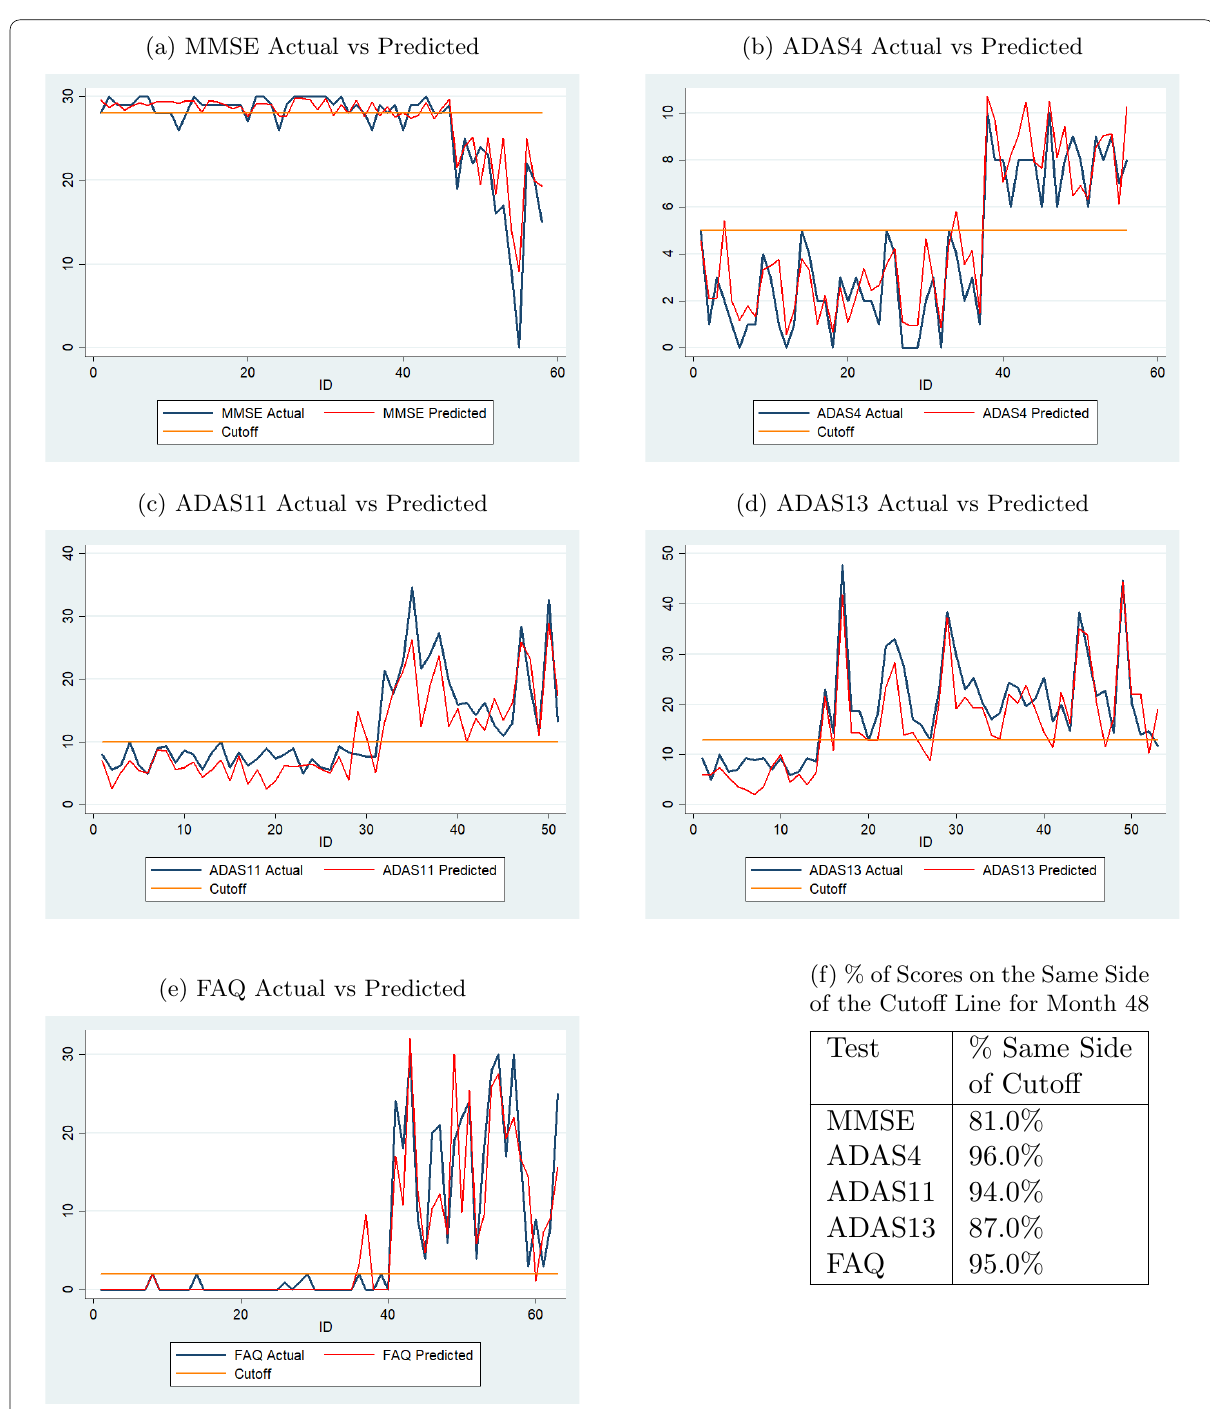
Fig. 9 Comparison of actual and predicted values by sequence prediction models at month 72 for validation data (with normal